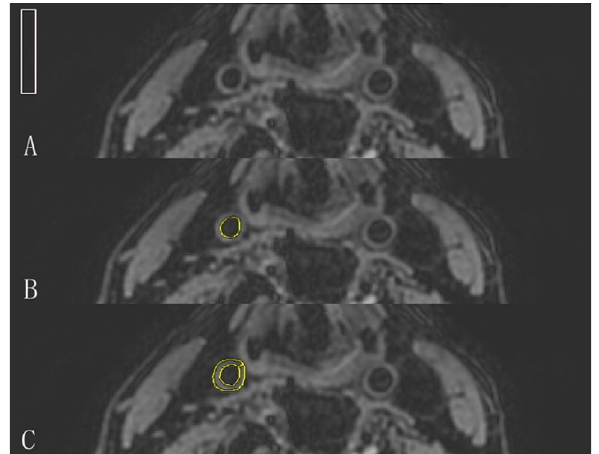
Figure 2. ( A ) One white region of interest (ROI) obtained from an artifact free background for the noise estimation. This ROI was positioned on the same layer as ROI of carotid wall and lumen and was of the same relative size on different subjects; ( B ) one yellow ROI obtained from the lumen of the common carotid artery (CCA); and ( C ) one yellow ROI obtained from wall of the CCA.